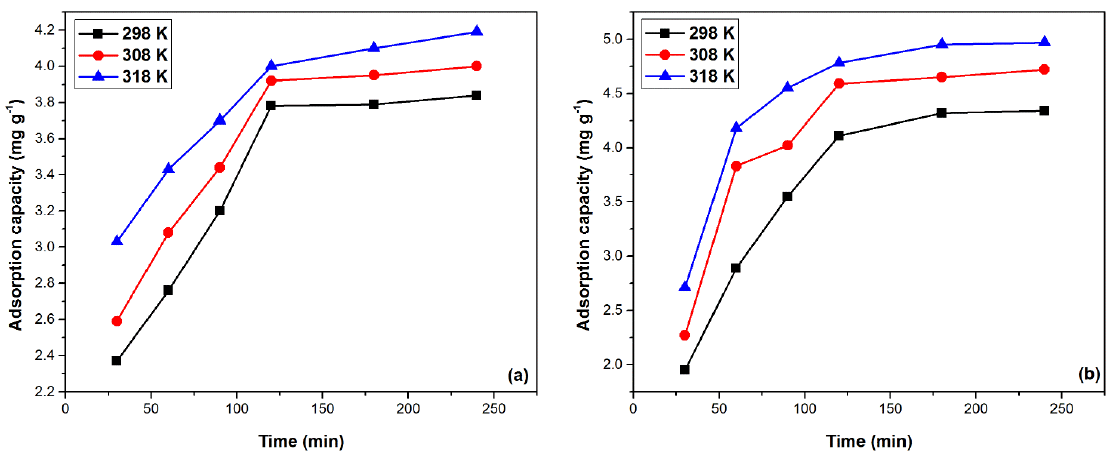
Figure 7. Contact time and temperature effect on the adsorption capacity of the functionalized adsorbents: ( a ) MgSiO 3 - DB18C6, ( b ) MgSiO 3 -DB30C10.